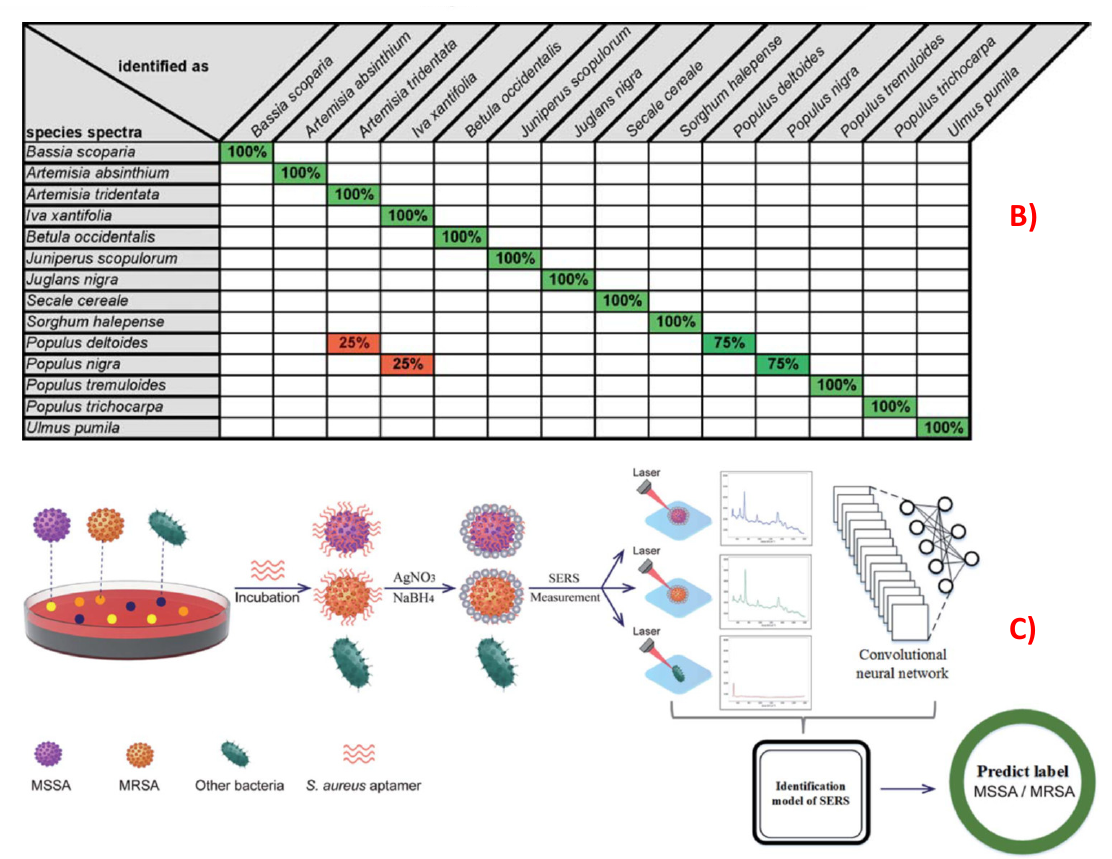
Figure 8. Applications of machine learning techniques used in the identification of biological samples, using the SERS technique for the ( A ) identification of lung and colon cancers from exosomes HCT-116 (colon cancer biomarker), A549 (lung cancer biomarker), and non-cancerous samples performed with ( a ) PCA, ( b ) PLSDA, and ( c ) SVM, with 60% of training set and 40% of test set. ( d ) Predicted labels for the test set using the SVM model. Value 1 is a prediction for normal plasma, Value 2 is a prediction for A549 (lung cancer) exosomes, and Value 3 is a prediction for HCT-116 (colon cancer) exosomes. The highlighted portion shows labels that are wrongly identified. Reproduced with permission from [382]. Copyright (2022), Elsevier. ( B ) Identification of 14 commercially available pollen species using SERS spectra combined with an artificial neural network, using a winner-takes-all (WTA) method. Reproduced with permission from [384]. Copyright (2015), Wiley. ( C ) Schematic for SERS based ML model used in the identification of methicillin susceptible Staphylococcus aureus (MSSA) and methicillin resistant Staphylococcus aureus (MRSA) bacteria, using a CNN model. Reproduced with permission from [379]. Copyright (2021), RSC.